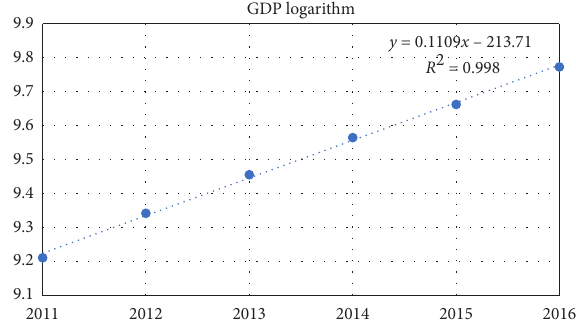
Figure 5: GDP growth rate fitting chart. Table 2: Setting of constant values of the